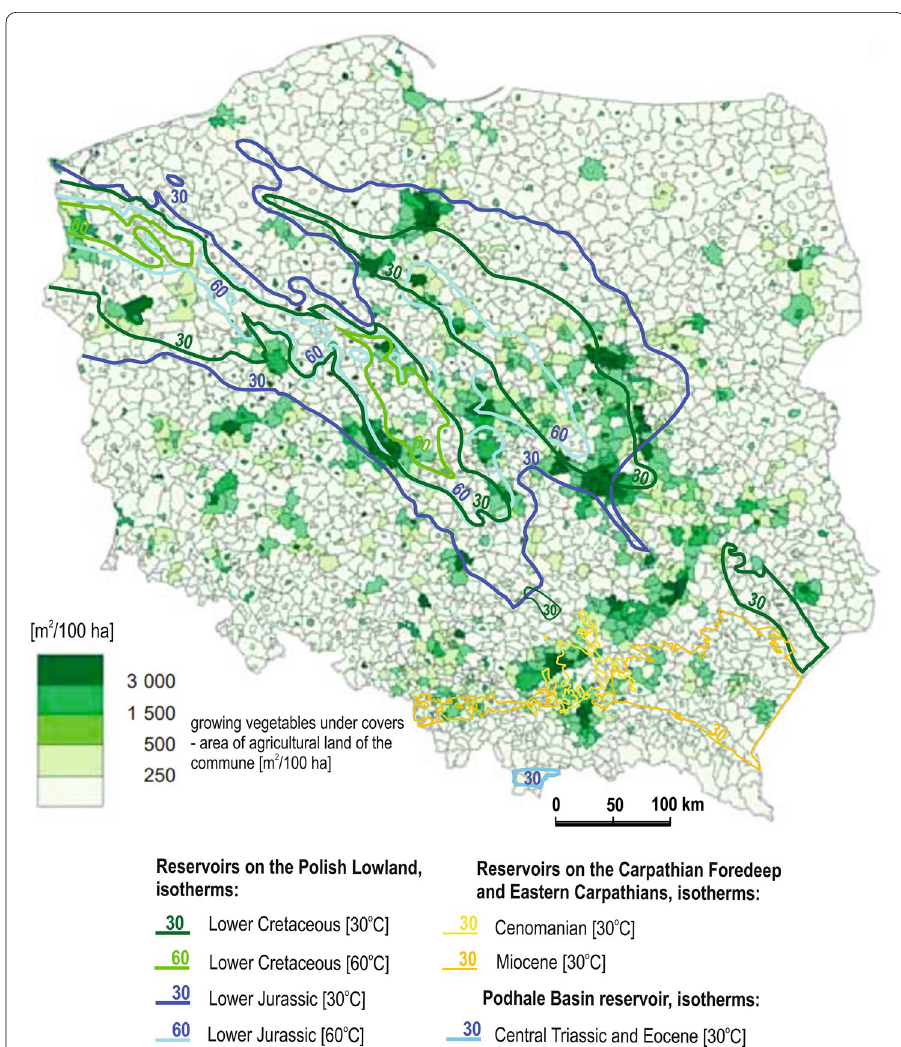
Fig. 8 Geothermal water reservoirs proposed for agricultural uses in Poland against the map of cultivated vegetables under covers. Scientific description based on Barbacki et al. (2016); ranges of reservoirs with temperatures > 30 ◦ C and > 60 ◦ C according to maps by Górecki et al. (2006, 2011, 2012, 2013); underlay Map of vegetables crops under cover (2002 [in:] Kulikowski